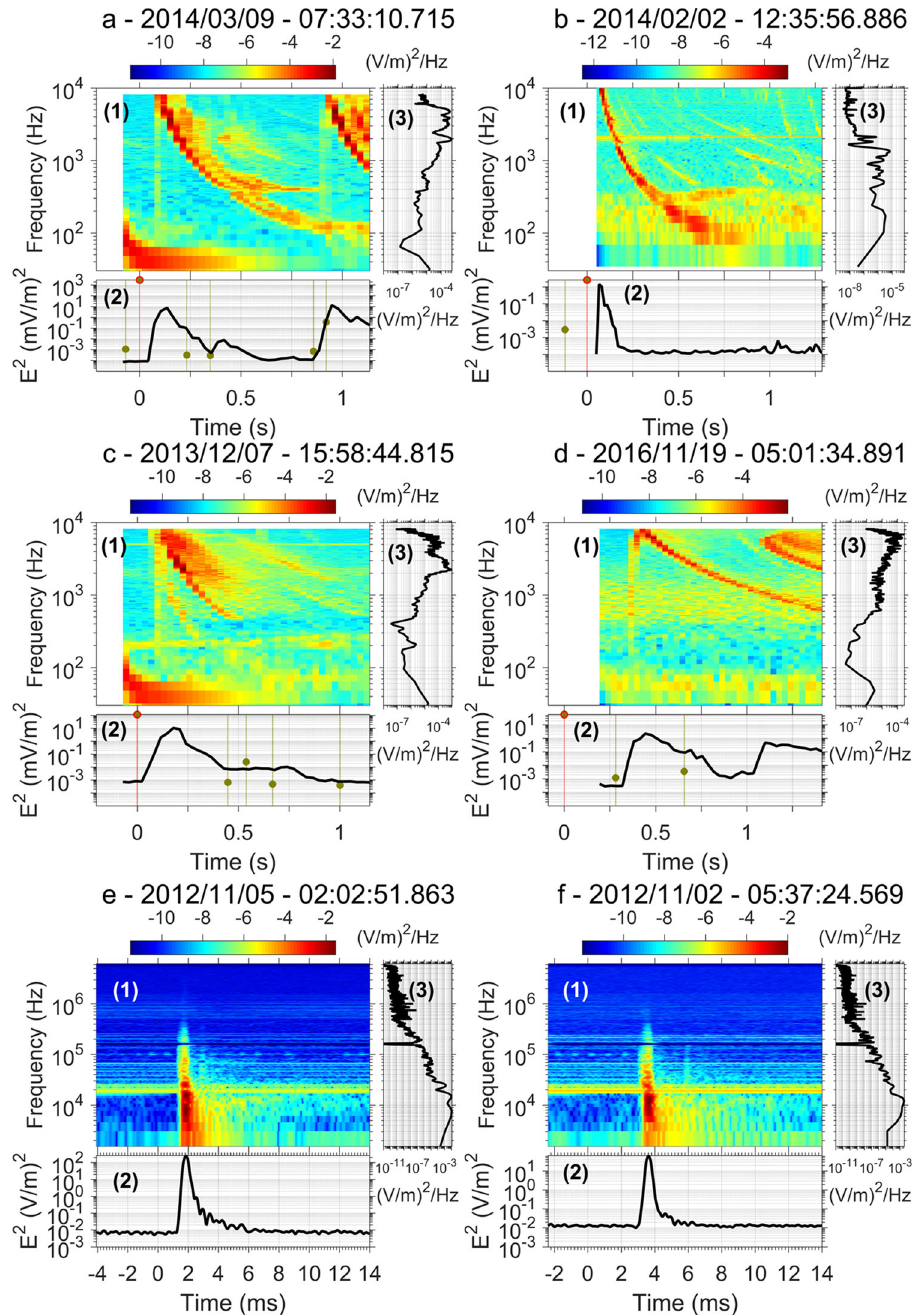
Fig. 2 Superbolt ’ s electric power from space and ground-based measurements. a – f Show electric power spectral density and squared electric fi eld (intensity) versus time for six different superbolts measured either ( a – d ) in burst mode in space (PSD in mV 2 /m 2 /Hz) or ( e , f ) on the ground (PSD in V 2 / m 2 /Hz). The speci fi cs of the events are in Supplementary Tables 2 and 3. Panel a1, b1, c1, d1, e1, f1 show the evolving power spectral density. Panel a2, b2, c2, d2, e2, f2 show the evolving wave electric fi eld intensity. Panel a3, b3, c3, d3, e3, f3 show the average of the PSD over 1 s (in V 2 /m 2 /Hz). Dashed vertical lines in the line plots (a2 – f2) show times of all WWLLN-detected lightning during that time interval. Circles in the line plots (a2 – f2) indicate an estimate of the median squared electric fi eld in space based on WWLLN-measured lightning energy (computed from ref. 22 ). The non-superbolt median squared electric fi eld estimates (green circles) are found to be >3 orders of magnitude less than the superbolt estimates (green circle with a red contour), con fi rming that the detected space-based signals correspond to the WWLLN superbolt, and are not caused by other lightning. Continuous signal at ~20 kHz (e1 – f1) is due to a powerful VLF ground transmitter and should be disregarded. The sharp rising tone just prior to the main whistler pro fi le in (a1, c1, d1), best seen in (d1) at t = 0.4 s for frequencies within 10 2 and 10 4 Hz, is an anti-aliasing fi lter effect with a fold over of the power above the top